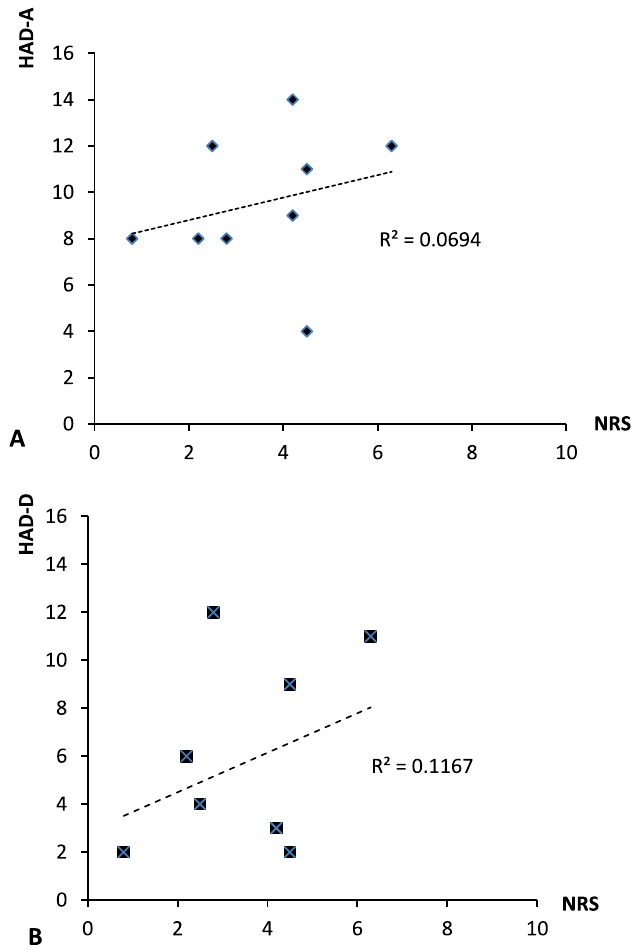
Fig. 2. HADS scores as a function of pain intensity in patients with PTTN ( n =9). (A) Anxiety scores (HAD-A). (B) Depression scores (HAD-D). Pearson ’ s correlation coef fi cients suggest a weak correlation between HADS and NRS scores. NRS =Numerical Rating Scale (0 – 10); HADS= Hospital Anxiety and Depression Scale: scores between 7 and 10 suggest probable anxiety/depression, over 10 certain anxiety/